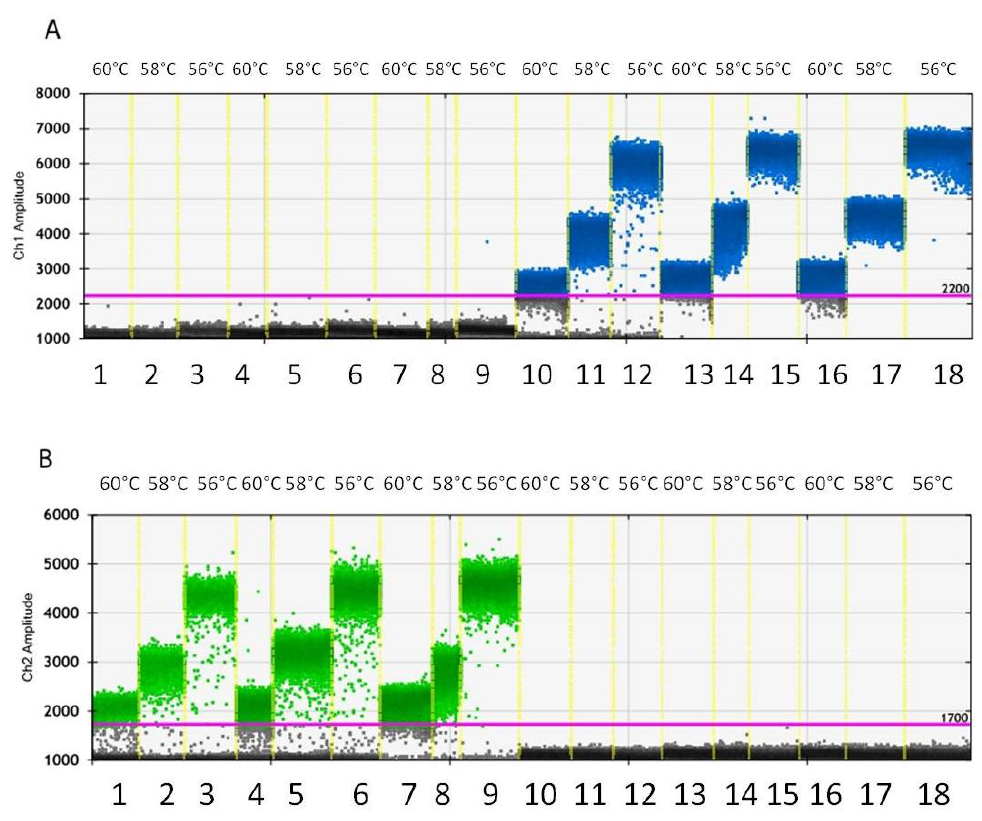
Figure 1. Amplitudes from channel 1 (FAM) ( A ) from channel 2 (HEX) ( B ) obtained during the first experiment to optimize the annealing/extension step and select the most performant DNA